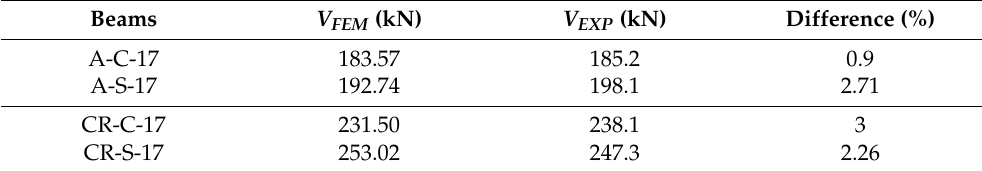
Table 7. Comparison of the shear strength of the beams from the numerical and experimental [37].